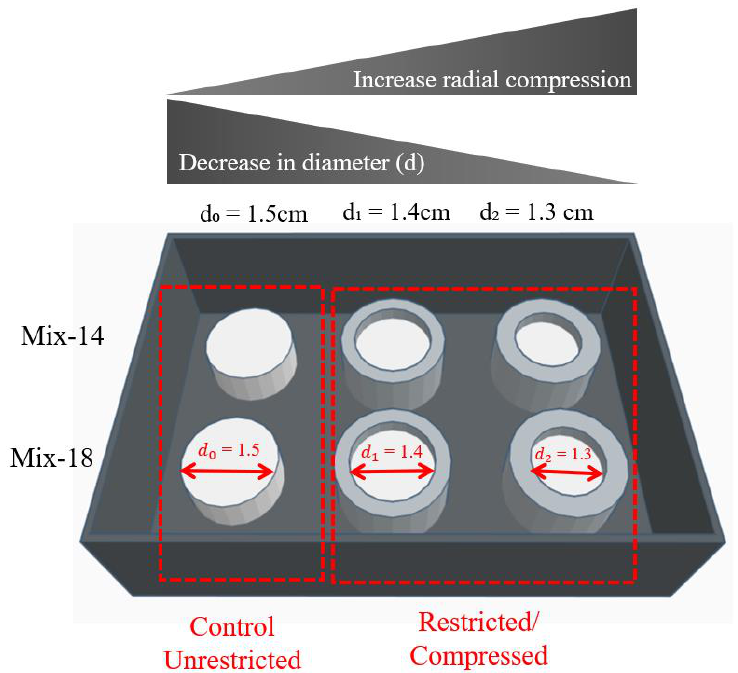
Figure 1. Diagram showing the setup used to build the custom designed radial compression apparatus. Left: unrestricted (control or d 0 = 1.5 cm) shape memory polyurethane aerogels (SSMPA). Center and right: SSMPA with increased degrees of radial compression and final diameters of d 1 = 1.4 cm and d 2 = 1.3 cm, respectively. Top: SSMPA Mix-14. Bottom: SSMPA Mix-18.